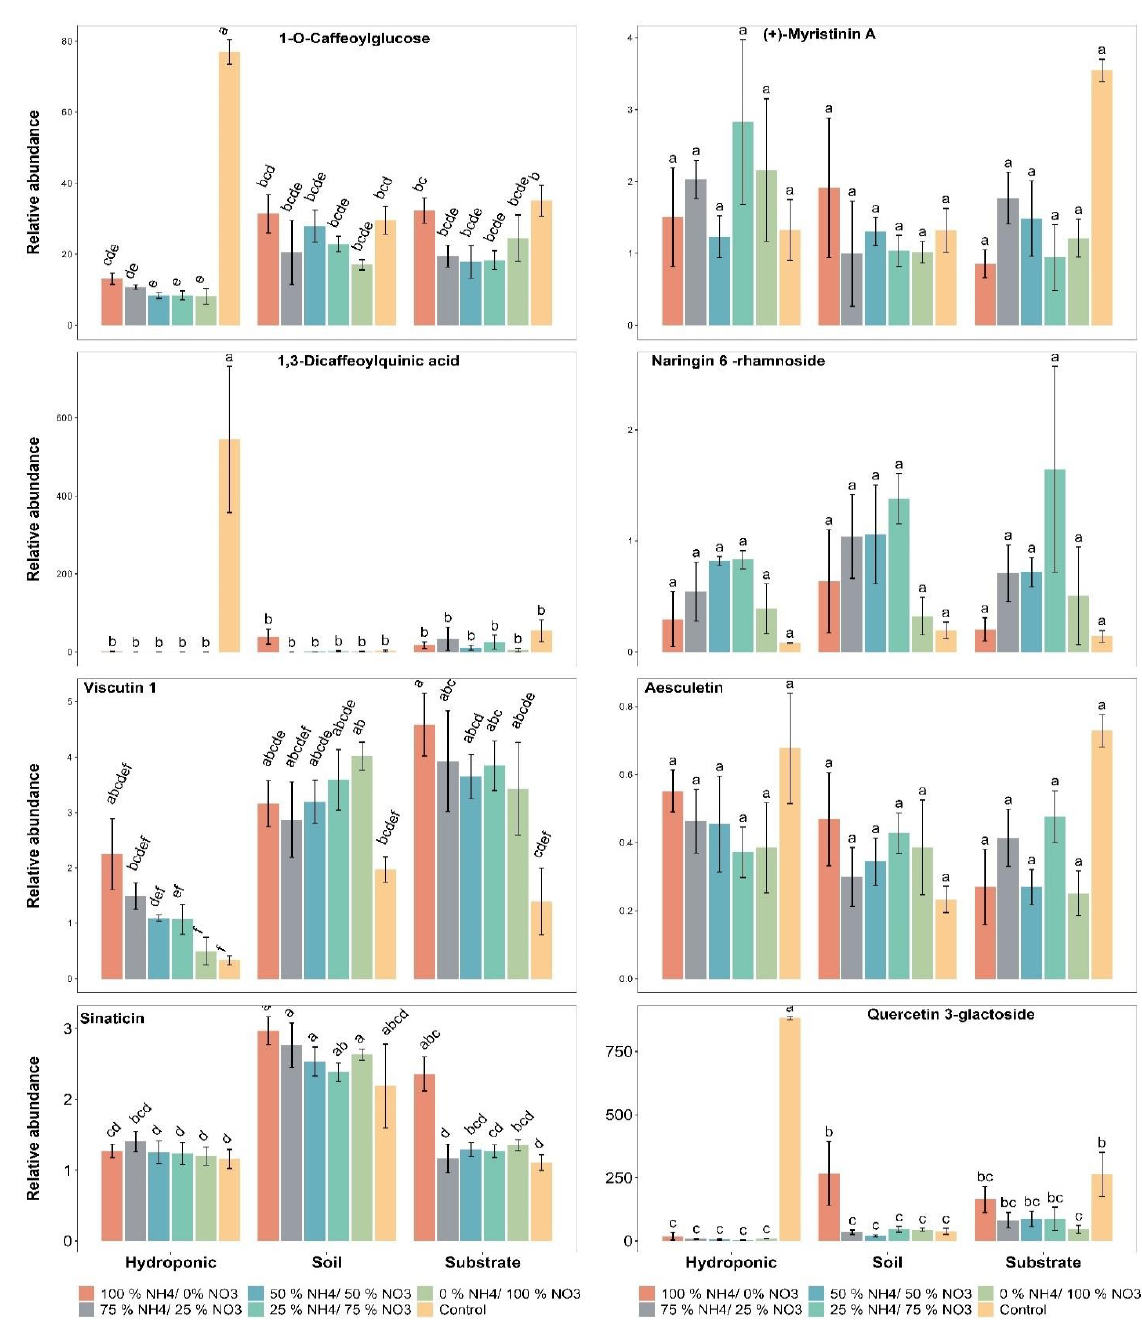
Figure 6. Effect of various applied NH 4+ /NO 3 − ratios (100:0, 75:25, 50:50, 25:75 and 0:100%) and control (no additional N applied) on different polyphenolic compounds in lettuce grown in soil, substrate and hydroponic cultivation systems. Note- The means ( n = 4) ± standard errors are shown in the data. Different letters (a–f) show significant difference ( p = 0.001) among applied NH 4+ /NO 3 − ratios (100:0, 75:25, 50:50, 25:75 and 0:100%) and control in lettuce grown in soil, substrate and hydroponic cultivation systems